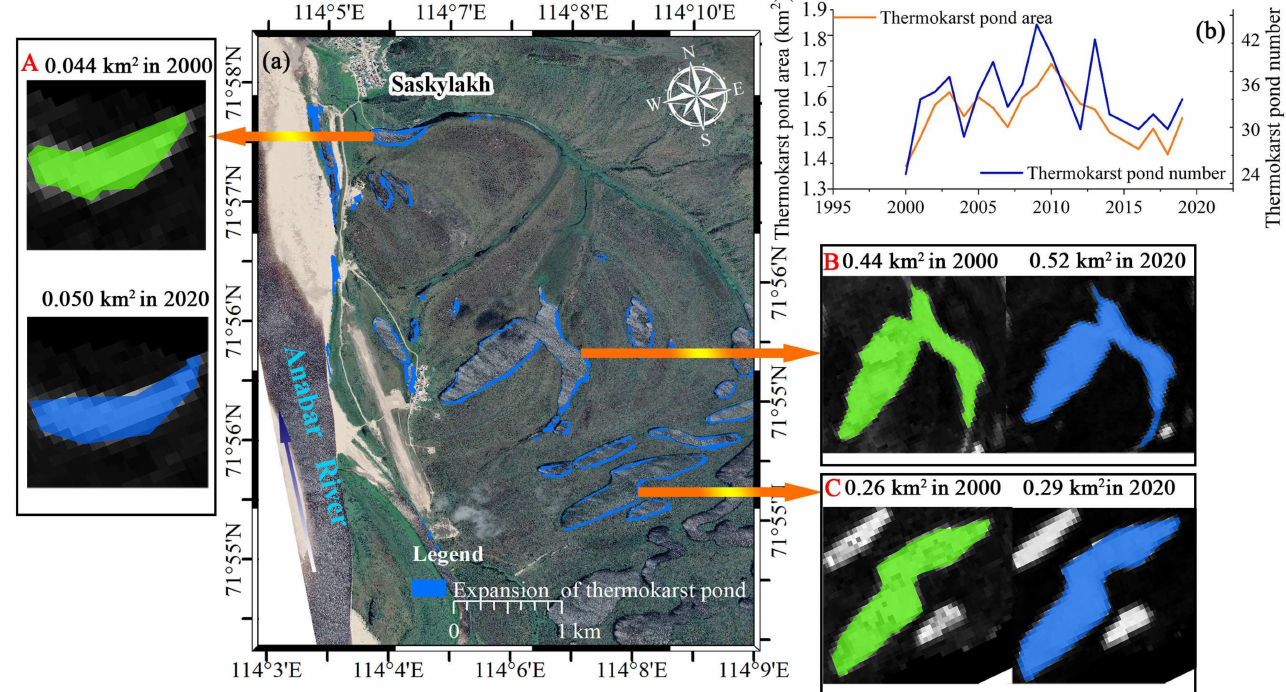
Figure 7. Expansion of perennial thermokarst lakes and ponds at Saskylakh, Anabarsky District,